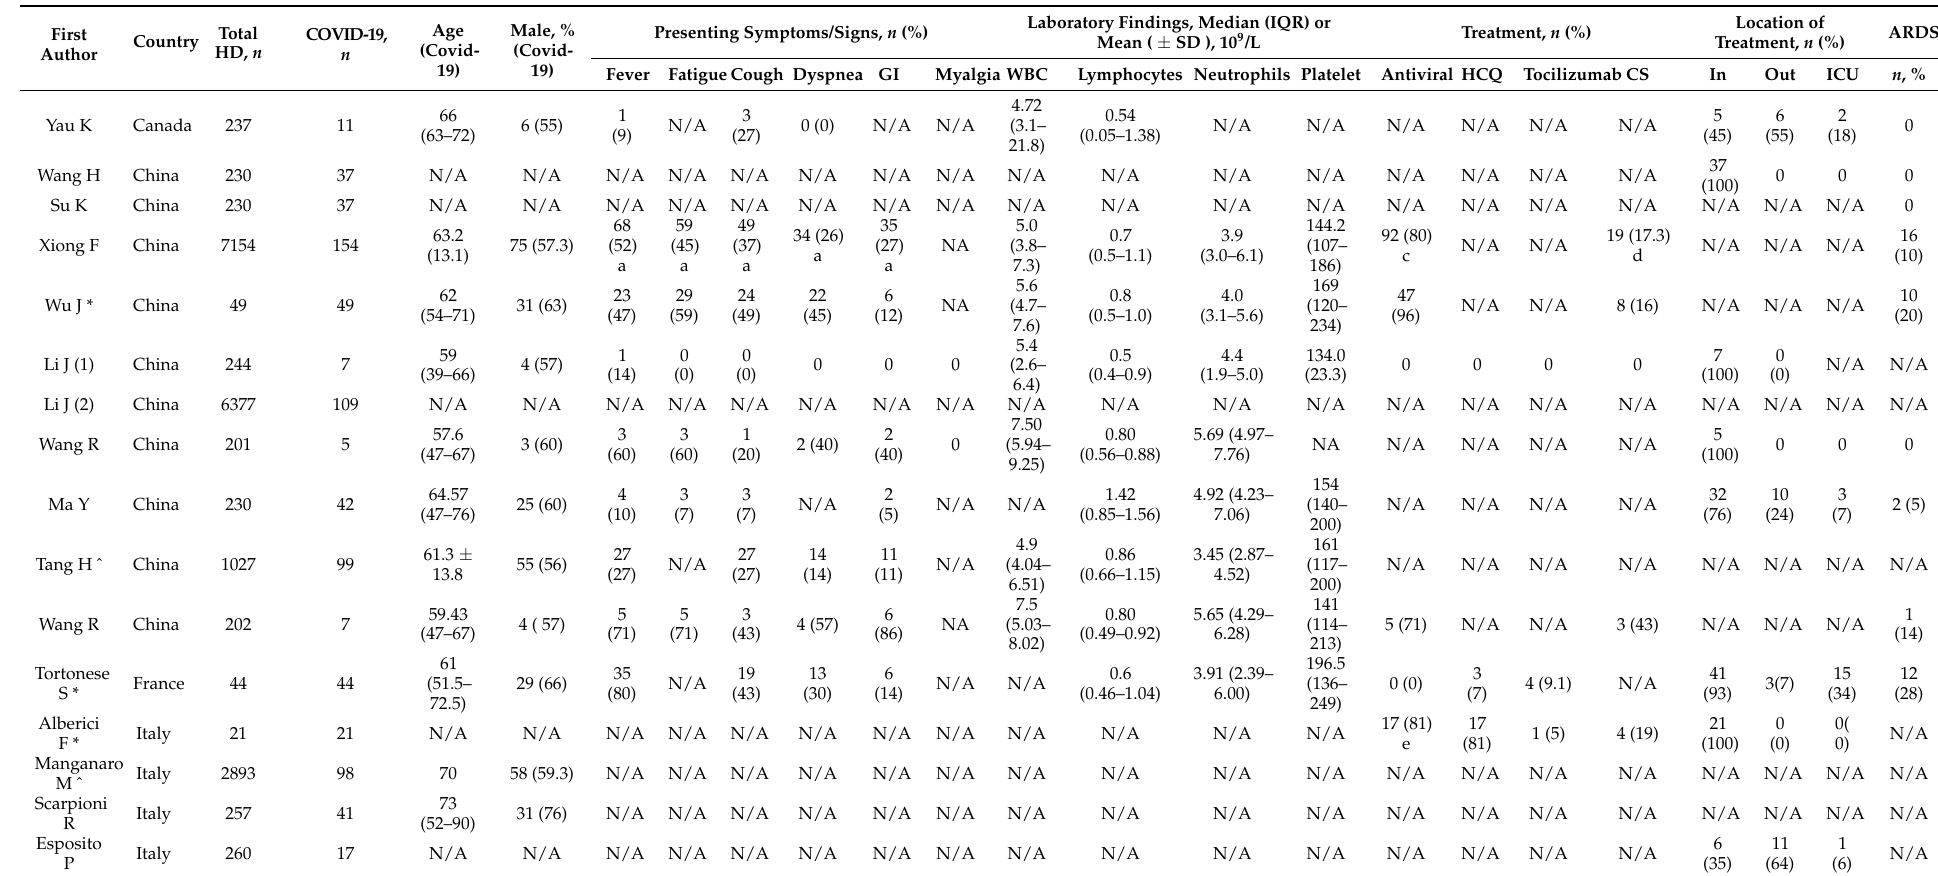
Table 1. Characteristics of studies reporting COVID-19 infection in hemodialysis